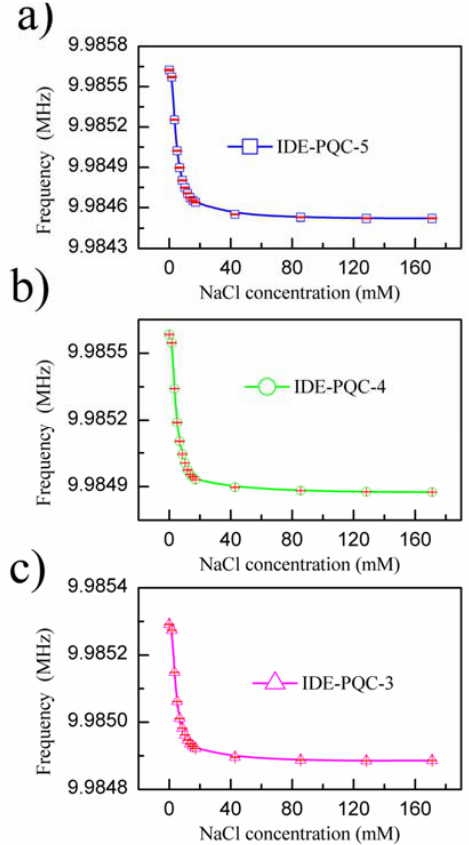
Figure 8. The response with error bar of IDE-PQC sensor. The error bar represents standard deviation from the mean.